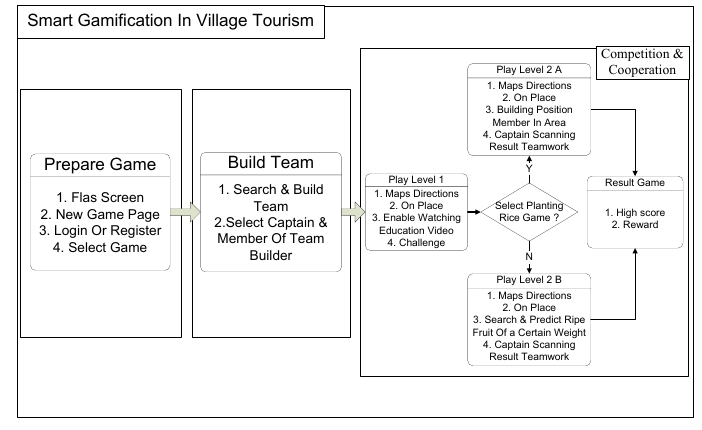
Fig. 1. The proposed